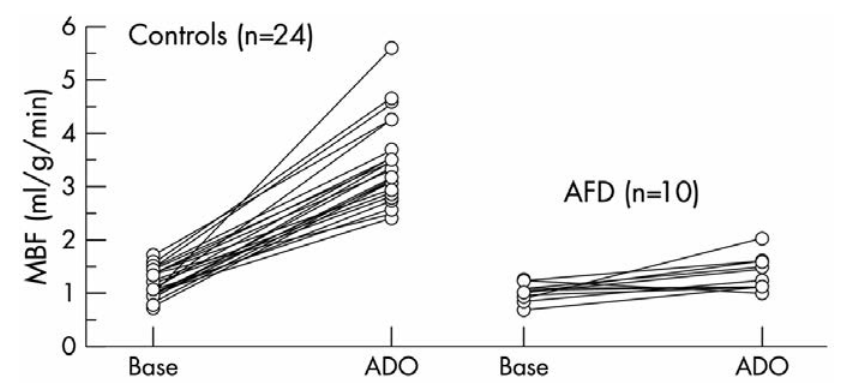
Figure 8. Microvascular dysfunction detected by myocardial positron emission tomogra- phy. Male patients with Anderson-Fabry disease (AFD) show a marked reduction in myocardial blood flow (MBF) during adenosine-induced hyperaemia (ADO), compared to controls ( Reprinted with permission of the publisher from Elliott et al. 59